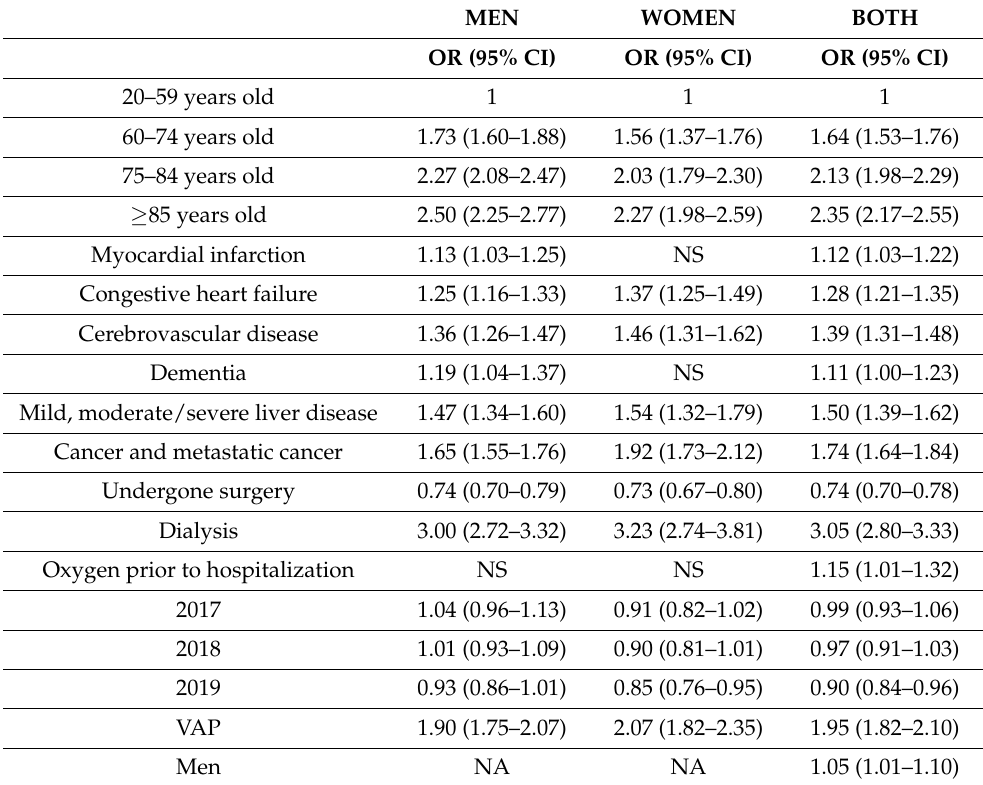
Table 6. Multivariable analysis of factors associated with in-hospital mortality in people who developed hospital-acquired pneumonia (HAP), according to